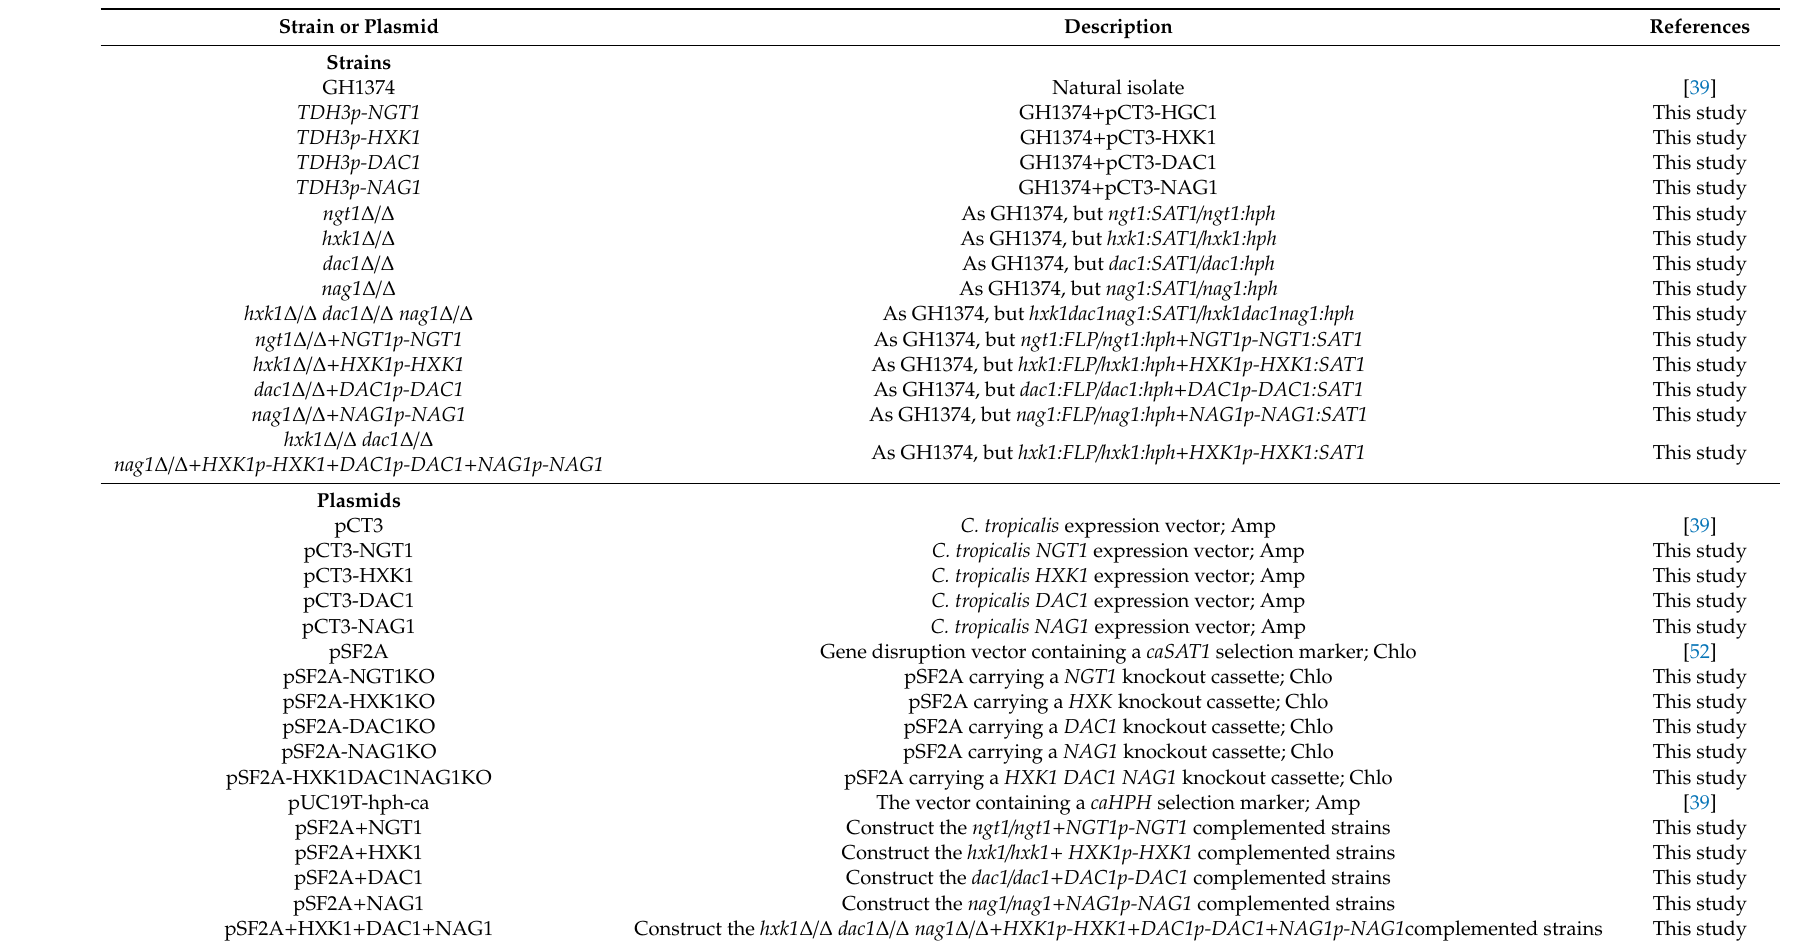
Table 1. Strains and plasmids in the present